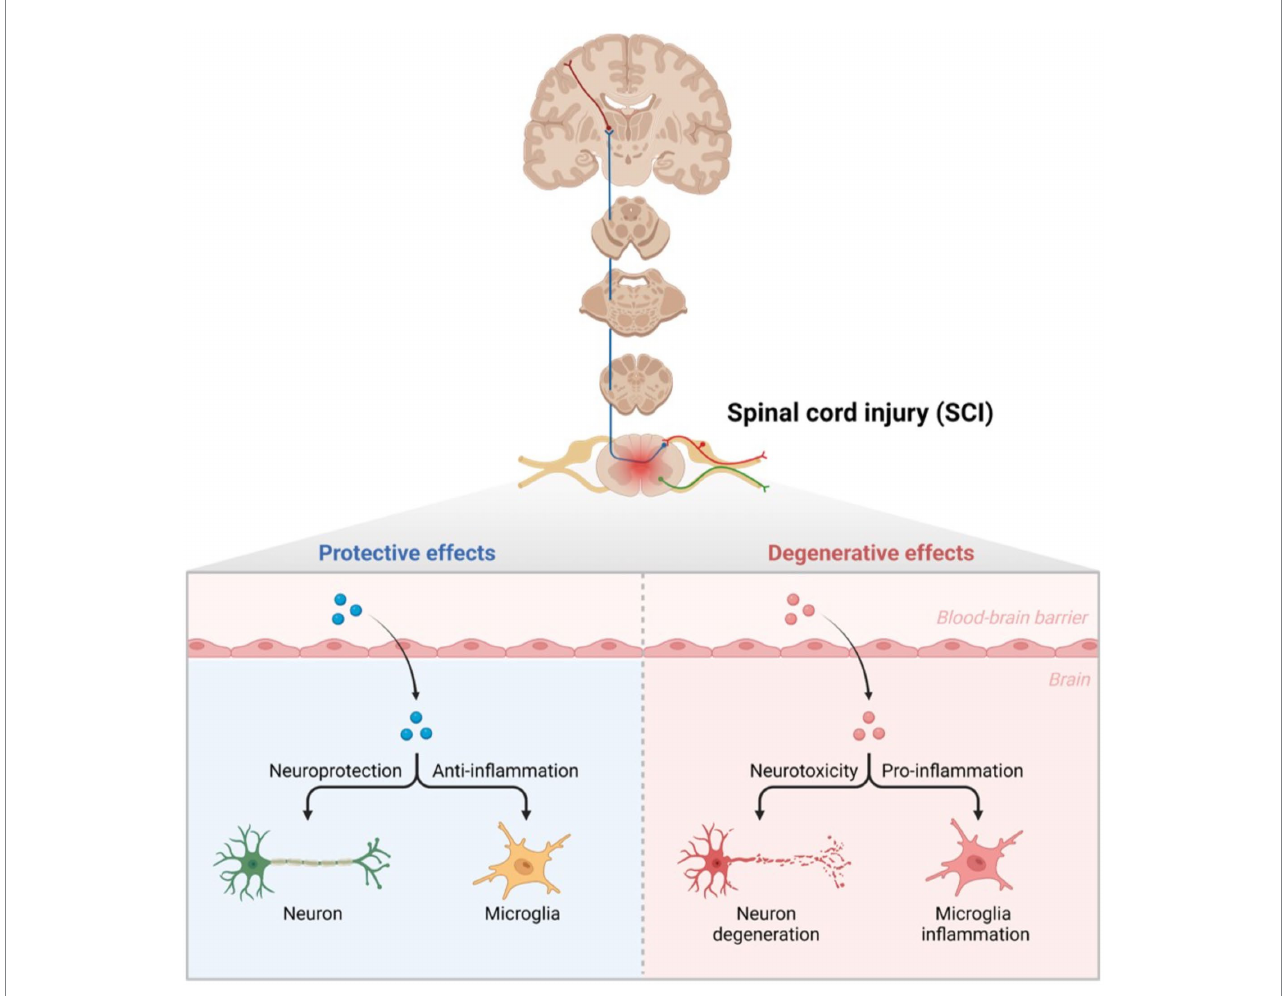
FIGURE 1 Glial cells in secondary injury after SCI. Normally, neurons play a protective role, and microglia resist the inflammatory response. Once SCI occurs, the blood–brain barrier is destroyed, leading to neuronal degeneration under the effect of neurotoxicity, and microglia cells play a pro-inflammatory